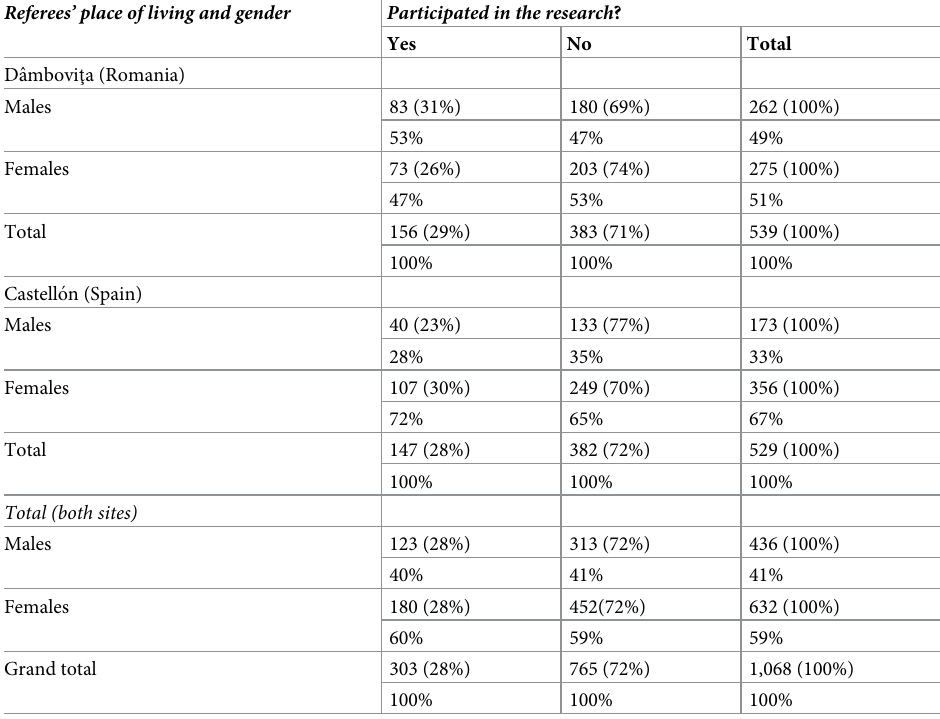
Table 3. Distribution of participation by referee’s gender and place of living. Referees’ place of living and gender Participated in the research ? Yes No